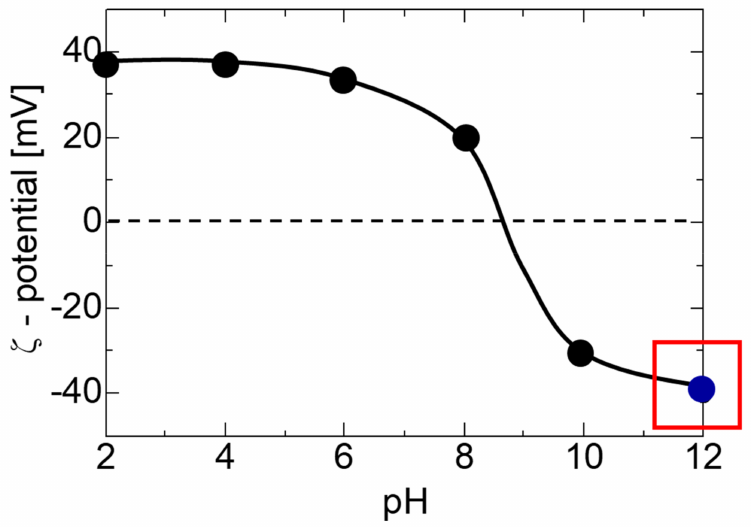
Figure 3. The zeta potential versus pH of an ITO nanoparticle suspension after the pH adjustment